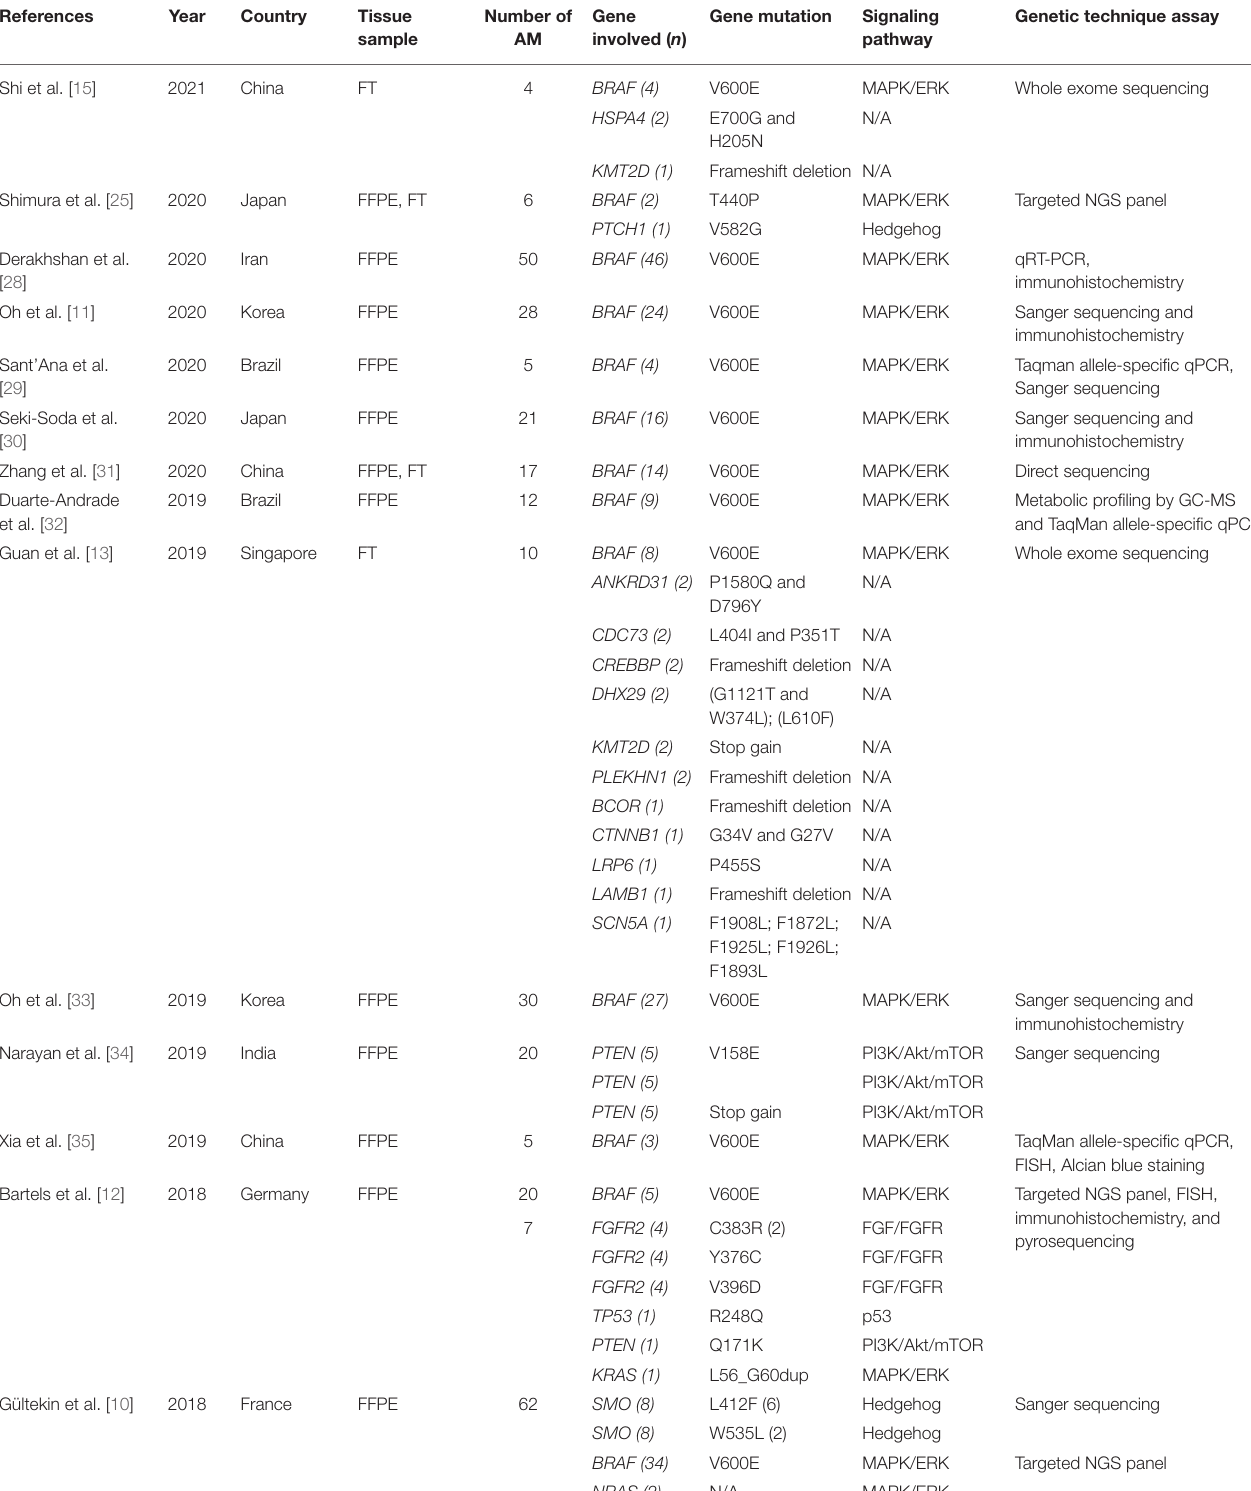
TABLE 3 | Gene mutations reported in